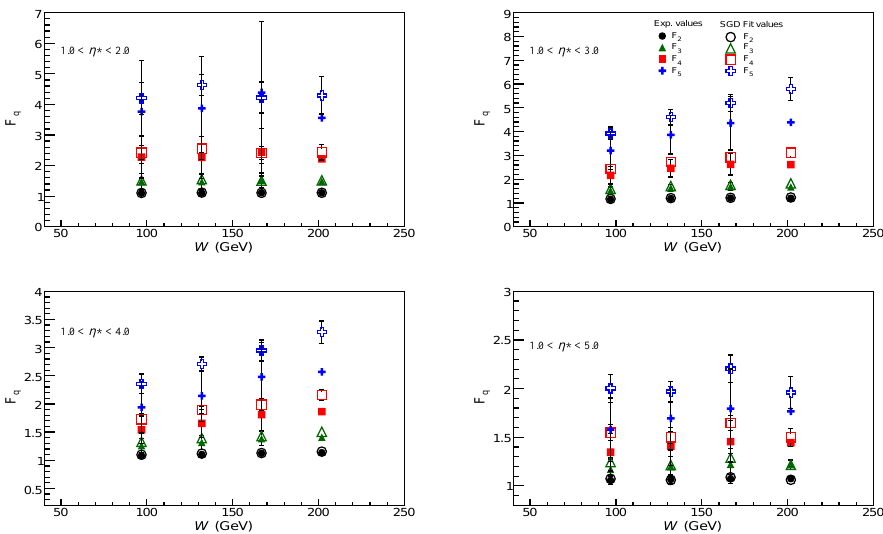
Figure 12. Normalized factorial moments F q for q = 2, 3, 4, 5 for the SGD fits and comparison with the values calculated from the data in different η ∗ ranges of H1 data [33].